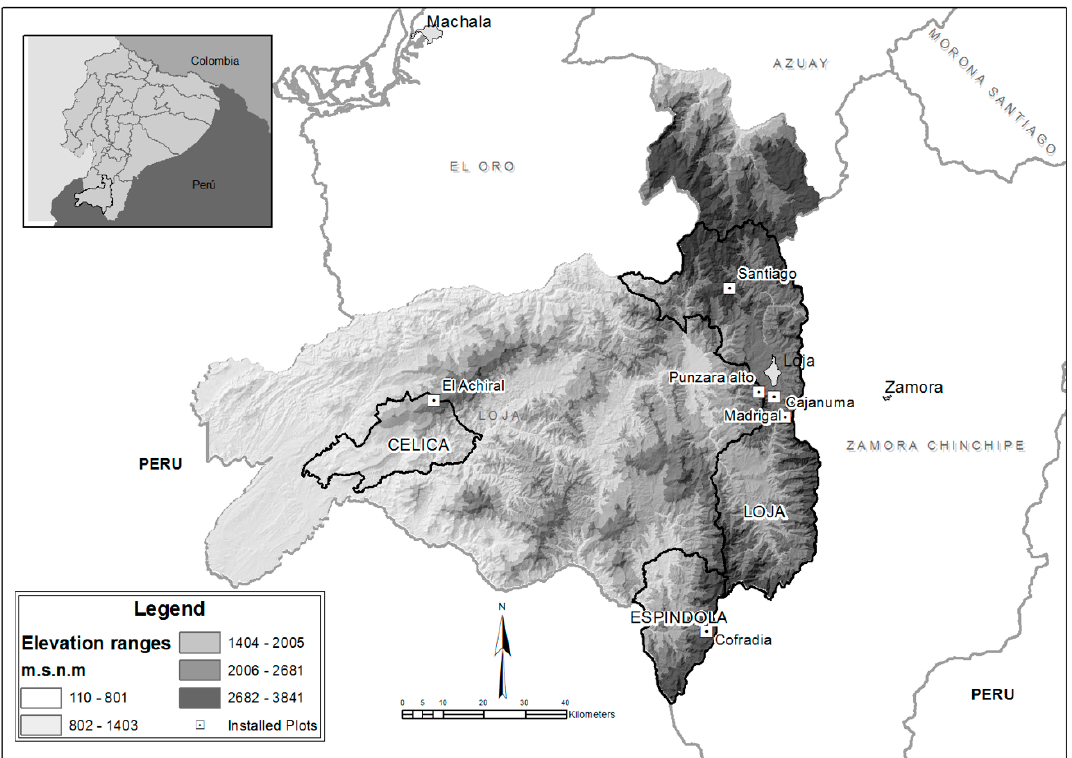
Figure 1. Map location of sampling plots.